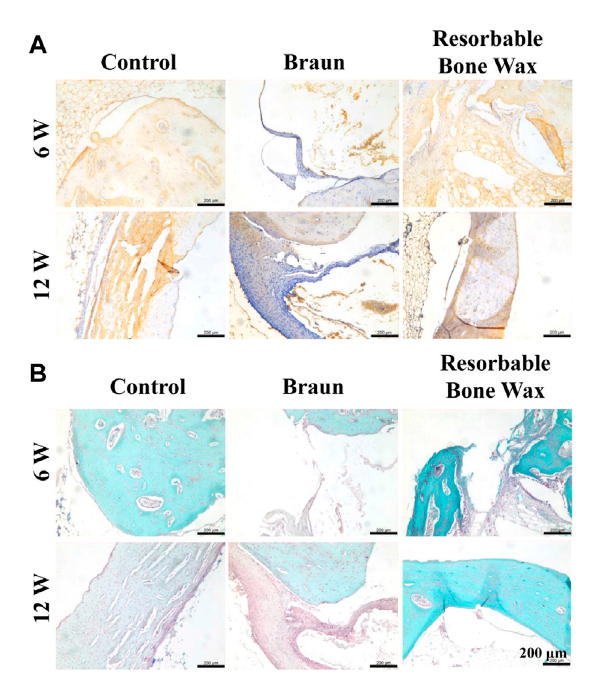
FIGURE 6 Histological staining of tibia. (A, B) Immunohistochemistry staining of OCN (A) and safranin O and Fast Green staining images (B) at defect sites 6 and 12 weeks